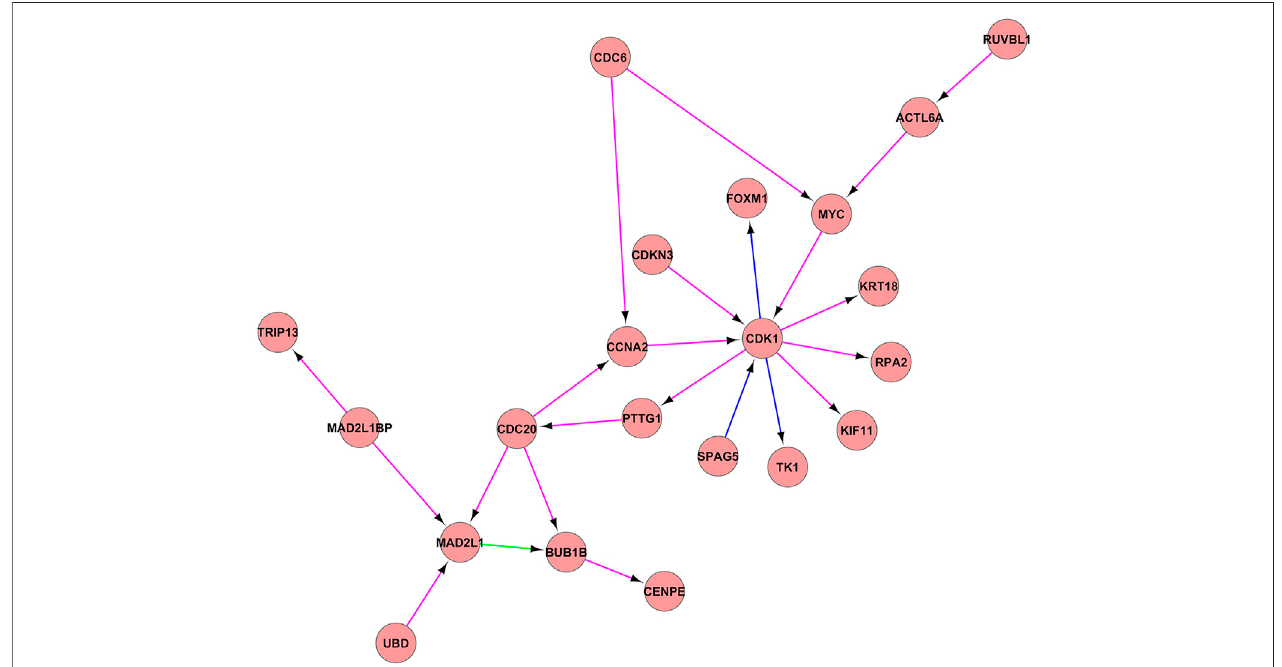
FIGURE3| PPInetworkbetweentheIC7_3andIC14_4.PPInetworkbetweentheIC7_3andIC14_4.Proteinsareillustratedwithcirclesanddirectedinteractions are illustrated with edges. Color of the edges represents the type of experiments used in HPRD database: blue — in vitro , red — in vivo , green — Y2H. This representation was obtained using Cytoscape software according to the HPRD